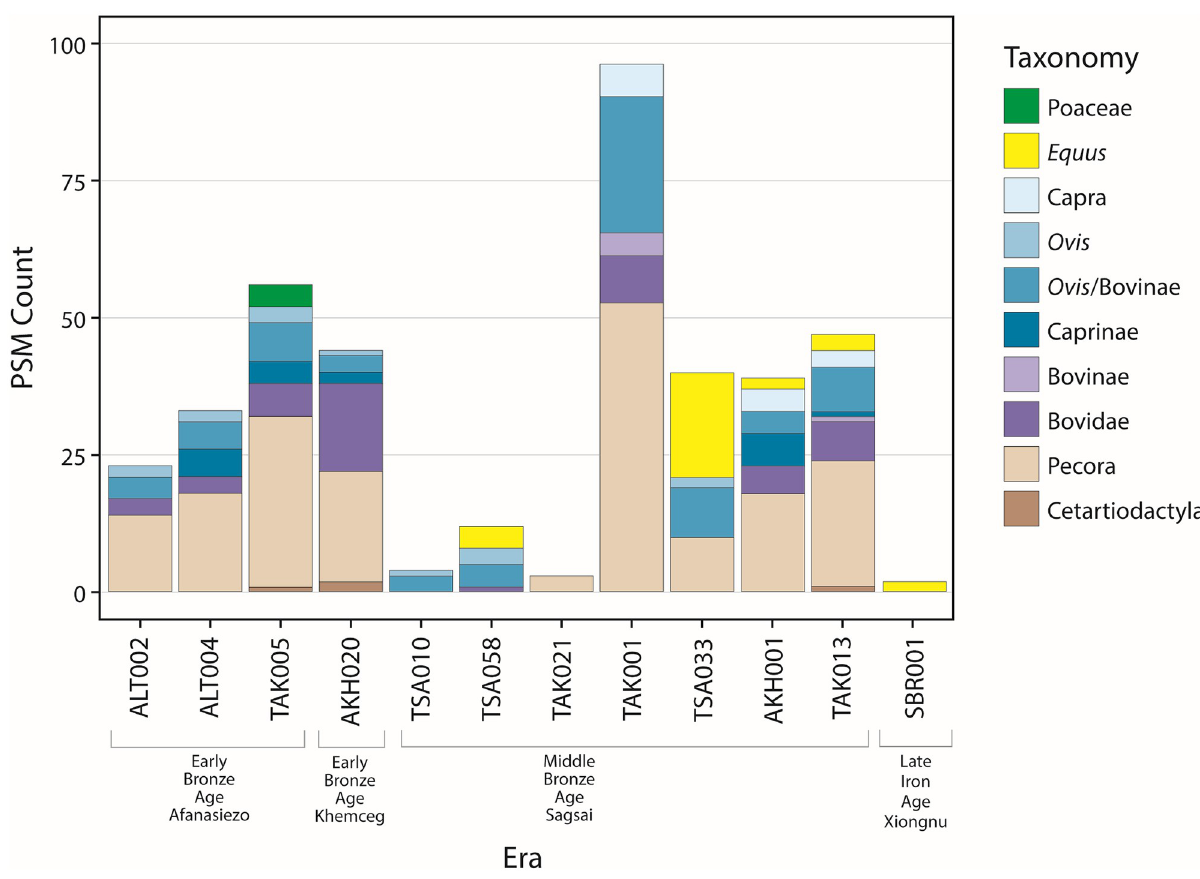
Fig 2. Bar plot showing the peptide spectral matches (PSMs) for each dietary protein per individual. Note the lack of dietary proteins in the SBR individuals, and see Supporting Note 1 and S1 Fig in S1 File. for corresponding preservation information for each